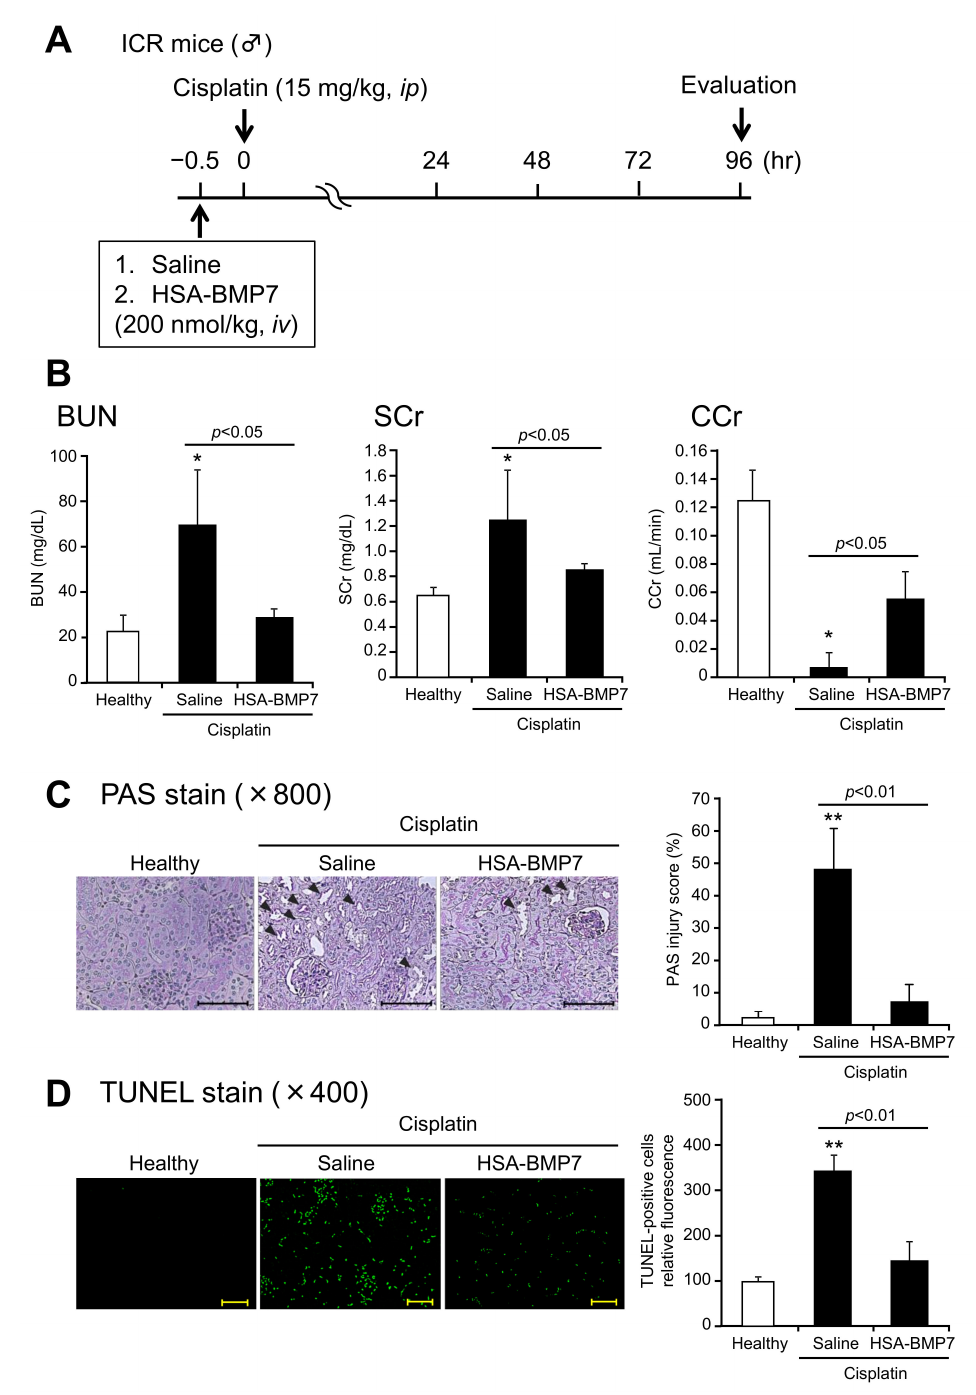
Figure 5. Effect of HSA-BMP7 on cisplatin-induced nephropathy. Experimental protocol for studying the effect of HSA-BMP7 against cisplatin-induced nephropathy mice ( A ). Saline or HSA-BMP7 (200 nmol/kg) was administered intravenously at 30 min before administering an intraperitoneal injection of cisplatin (15 mg/kg). Changes in the levels of blood urea nitrogen (BUN), serum creatinine (SCr) and creatinine clearance (CCr) after an intraperitoneal injection of cisplatin (15 mg/kg) ( B ). Results are the means ± SD ( n = 4–7). * p < 0.05, compared with healthy mice. Histological assessment and TUNEL staining of the kidney of cisplatin-treated mice ( C , D ). Representative photomicrograghs of PAS and TUNEL stained kidney sections. Original magnifications: × 800 ( C ); × 400 ( D ). Scale bars represent 100 µ m. The injured areas are indicated by arrows. The semi-quantitative analyses were also performed. Results are the mean ± SD ( n = 4–7). ** p < 0.05, compared with healthy